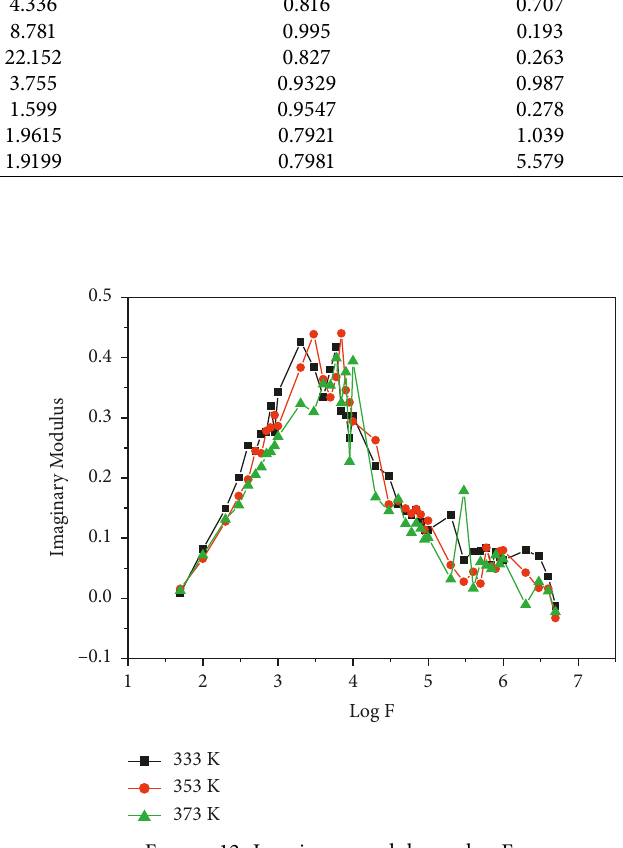
Figure 12: Imaginary modulus vs log